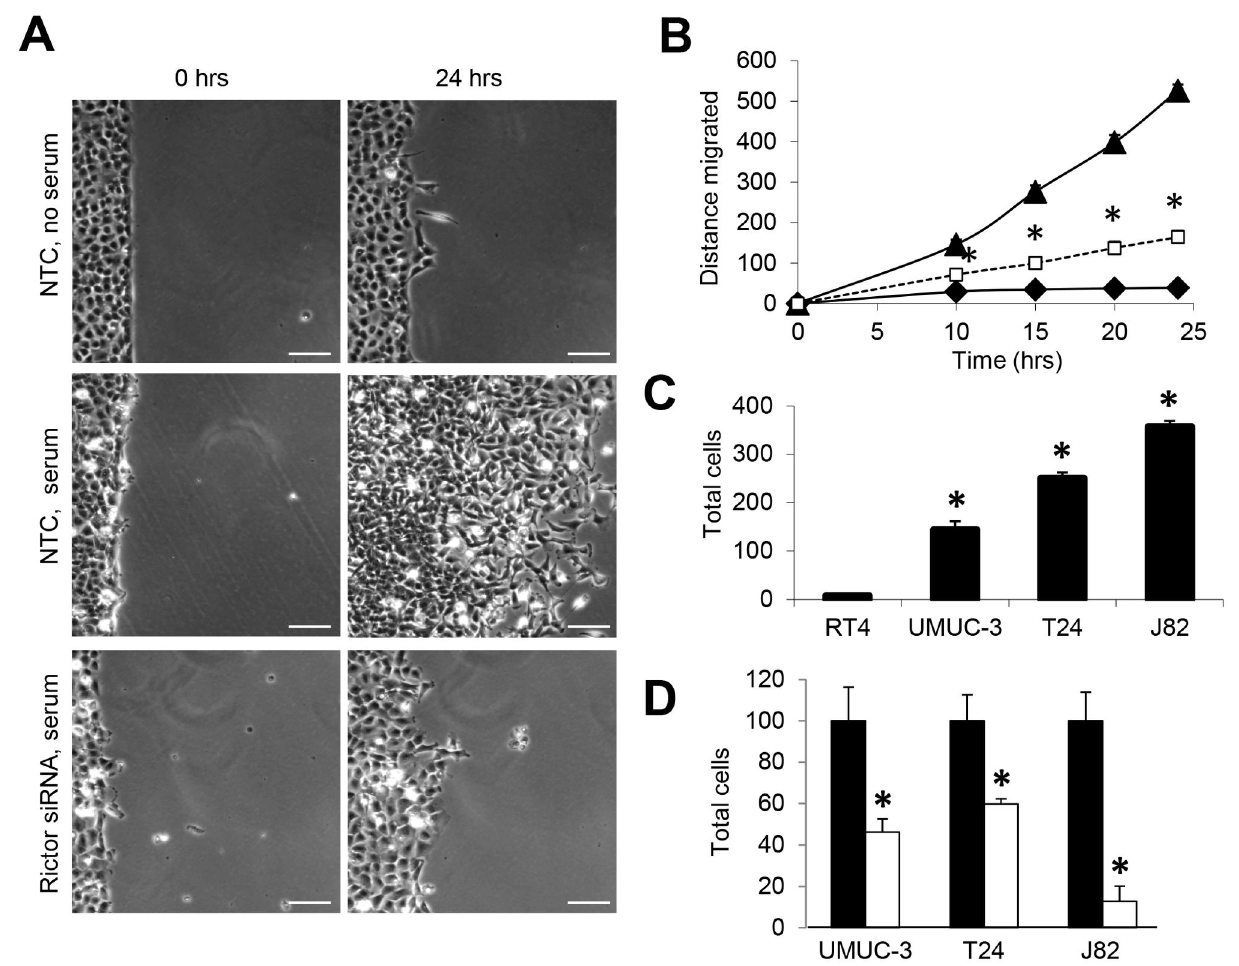
Figure 4. mTORC2 is critical in bladder cancer cell migration and transwell invasion. A , serum starvation blocked J82 bladder cancer cell motility. Addition of serum induced robust migration of J82 cells that were transfected with NTC siRNA, as determined using a modified scratch assay. Migration was inhibited by rictor gene-silencing. Scale bar 100 microns. B , quantification shows a reduction in the distance of migration of cells transfected with rictor-specific siRNA (□) compared with cells transfected with NTC siRNA (▲). Also shown are cells that were no serum-stimulated (♦). A total of 6 frames were analyzed for each time point per condition. C , transwell invasion on Matrigel-coated membranes shows higher numbers of malignant bladder cancer cells that invade. D, rictor gene-silencing significantly reduces cell invasion of all three malignant bladder cell lines in transwell assay. (*) statistically significant comparison using student t-test,